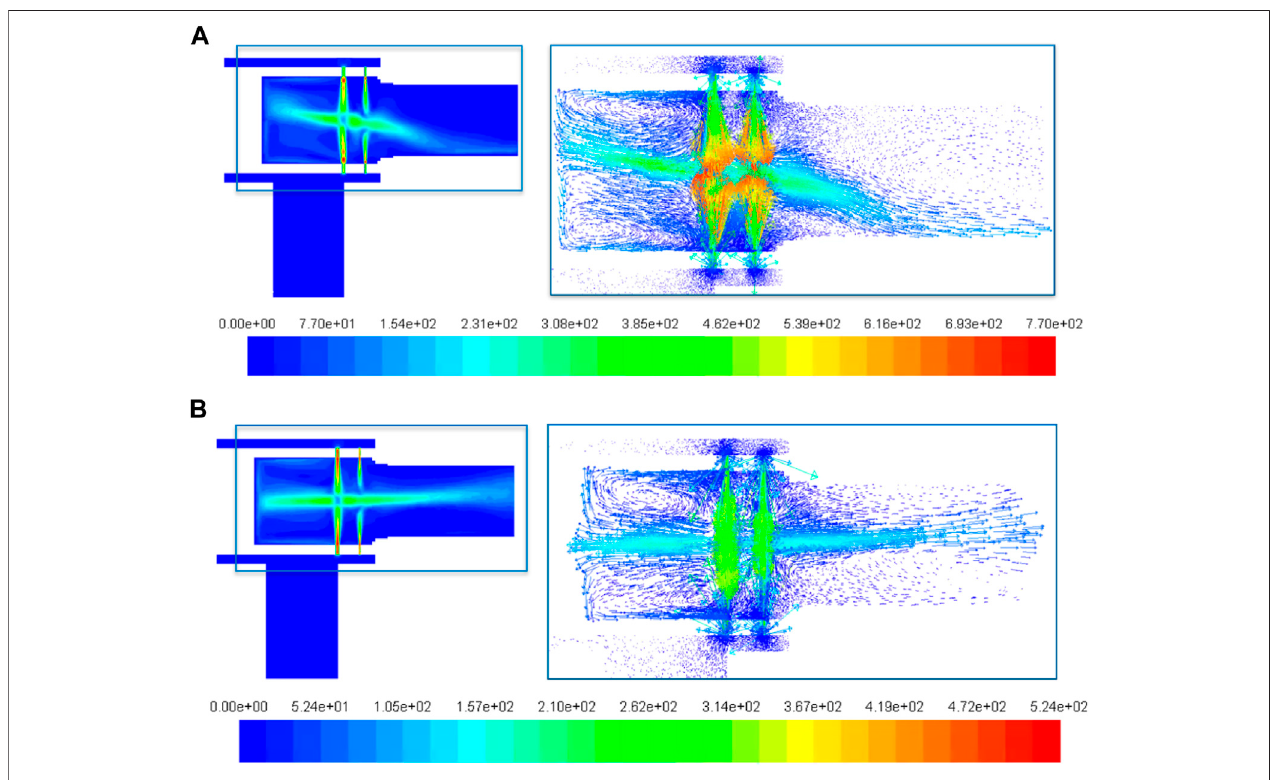
FIGURE 8 | The vertical pro fi le and vector diagram of throttling valve velocity under the pre fi lling pressure of 3 MPa (A) and 7 MPa (B) .